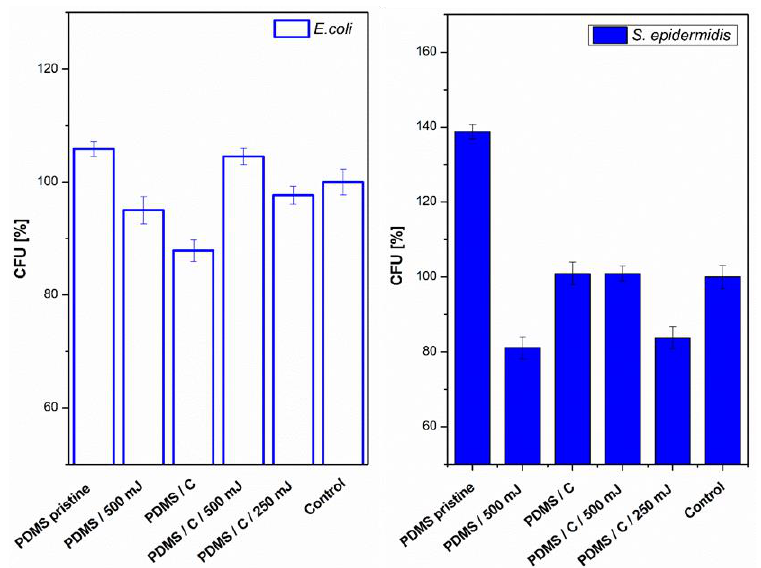
Figure 8. Antibacterial activity of polydimethylsiloxane (PDMS) samples against bacterial strains of S. epidermidis and E. coli after 4 h incubation. Samples: pristine PDMS, PDMS treated with high-energy laser (PDMS 500 mJ), PDMS composite with carbon (2 wt.%; PDMS/C), PDMS-C composite treated with 500 and 250 mJ, and control (bacteria in physiological solution). CFU represents colony-forming units grown on agar plates.